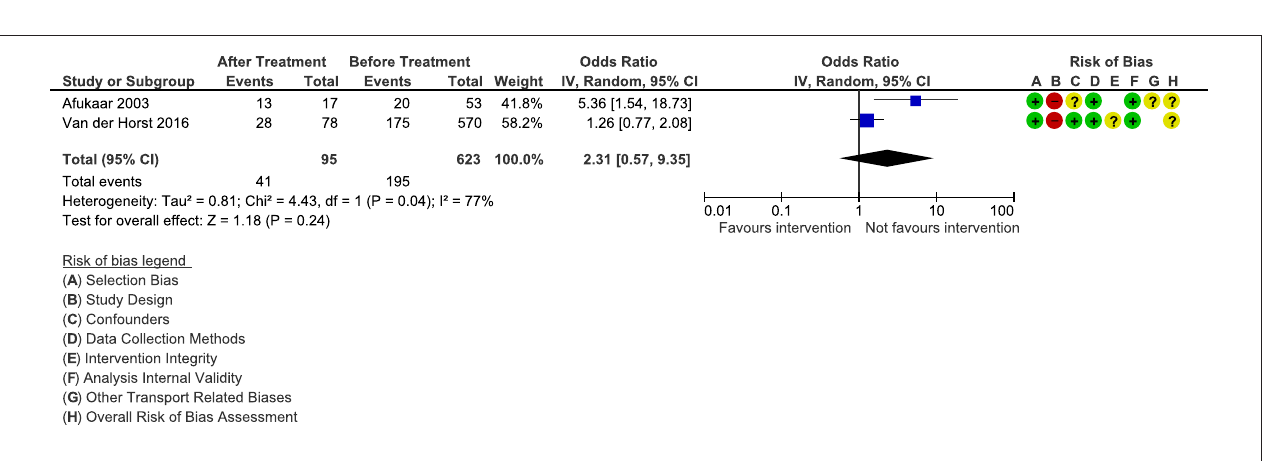
Frontiers in Sustainable Cities |